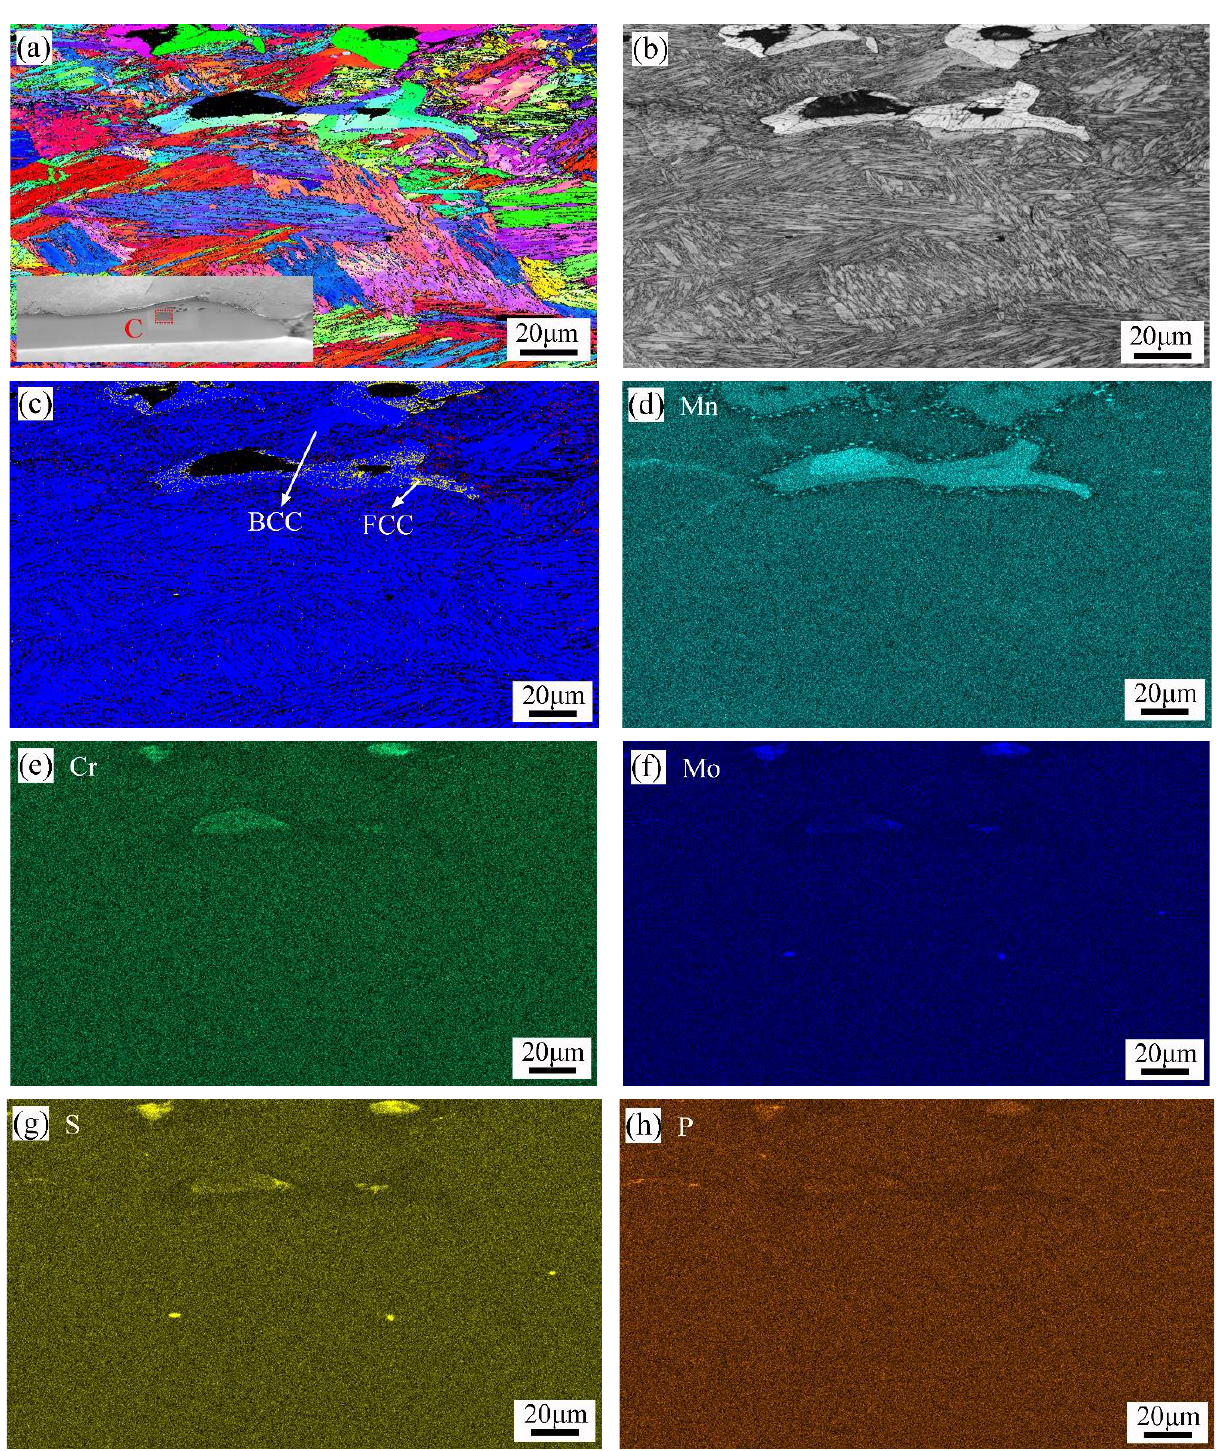
Figure 19. Microstructure and chemical composition distribution of location C: ( a ) IPF X; ( b ) band contrast map; ( c ) phase diagram; ( d ) Mn; ( e ) Cr; ( f ) Mo; ( g ) S; ( h )